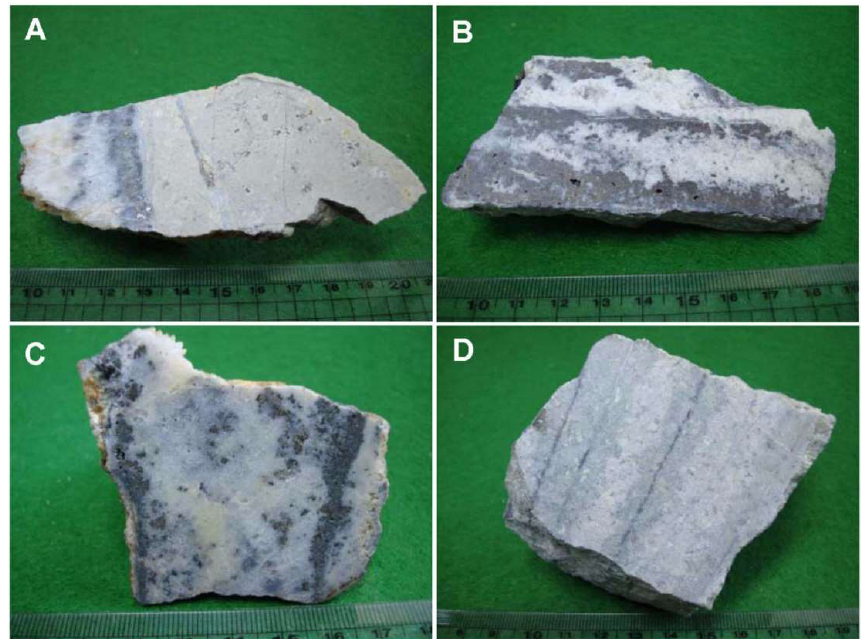
Figure 4. Photographs of high-grade ore specimens from the Eunjeok deposit. ( A ) Quartz vein showing comb structure as well as vug. Dark brown sphalerite, pyrite, chalcopyrite, galena, and arsenopyrite were observed. Sample No. EJ-3, Au 41.3 g/t, Ag, 206 g/t, ( B ) Comb textures with vuggy structures. Large amounts of fine-grained arsenopyrite were observed in quartz vein. Sample No. EJ-4, Au, 100 g/t, Ag, 216 g/t, ( C ) Within massive white quartz vein, large amounts of vugs developed. Fine-grained arsenopyrite observed with some pyrite and sphalerite. Sample No. EJ-5, Au, 131.6 g/t, Ag, 325 g/t, ( D ) Tuffs were altered, fine-grained galena and chalcopyrite concentrated along the fractures. Epidotization occur along the fractures. Sample No. EJ-10, Au, 29.8 g/t, Ag, 158g/t.